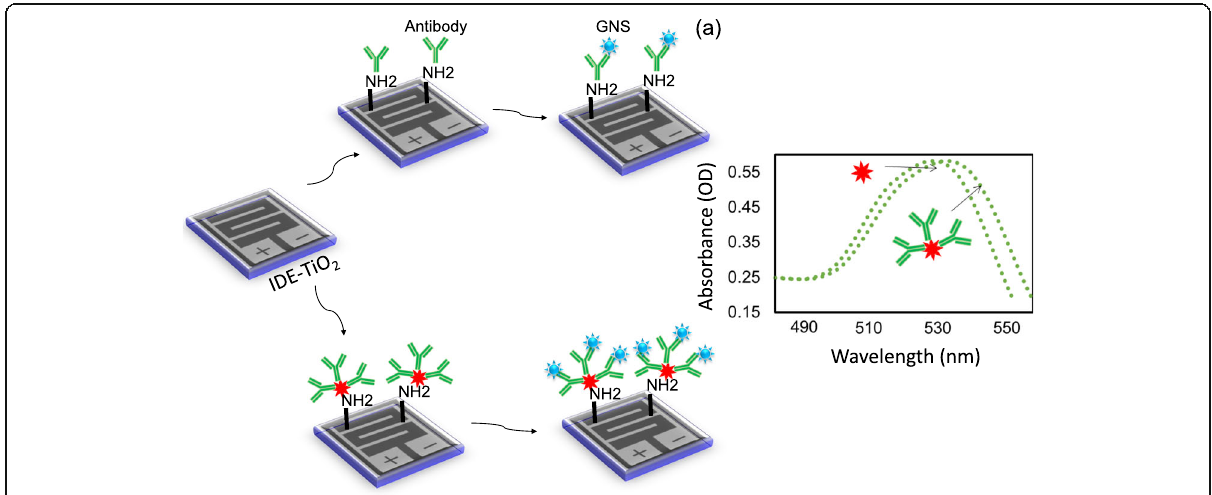
Fig. 1 a Schematic representation for the detection of SCC-Ag. IDE-TiO 2 surface was modified into amine by APTES followed by the immobilization of antibody or GNS antibody. The amine group from APTES react carboxyl group on the antibody. SCC-Ag was detected by the interaction at the antigenic region and compared. b UV-Vis spectroscopy measurements with GNS. Scanning was in the region between 480 and 560 nM, and the peak maxima were ~ 530 nM. GNS with and without antibody are indicated by the